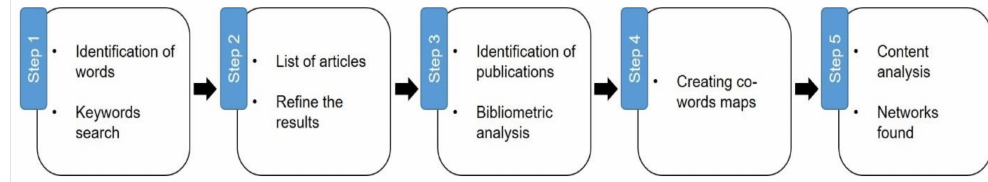
Figure 1. Schematic process of the bibliometric